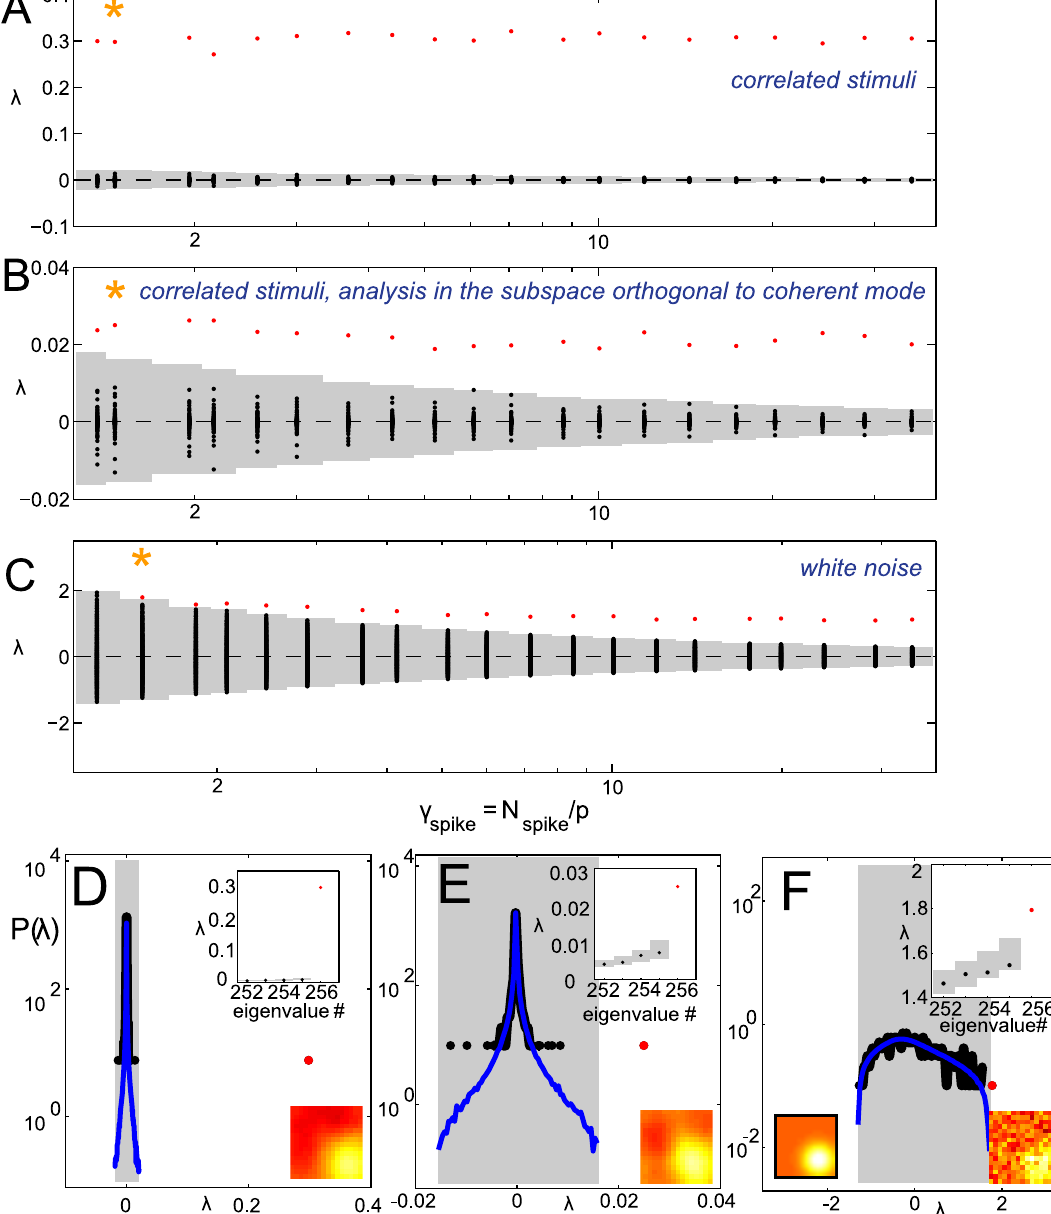
Figure 4. Spike triggered covariance analysis of a model neuron with one relevant feature that has a large component along the coherent mode. Spectra of D C for increasing dataset size in the case of strongly correlated Gaussian noise (A,B) and white noise (C). (A–C) The range of spikes covered is from N spike & 1 : 3 p to N spike & 34 p . Panel B shows the results after evaluating significance in the subspace orthogonal to the coherent mode. Each vertical line shows the result of a single simulation. Significant (insignificant) eigenvalues are shown in red (black), and the ½ 1,99 (cid:2) percentile range of the null distribution (1000 evaluations of D C null ) is shown in gray. (D–F) Gray shaded area is the support of the null distribution, which itself is plotted in blue. The correct feature is found using both stimulus conditions and both the original formulation of the STC method and our proposed correction. N ~ 1995 , N spike ~ 655 for the correlated stimulus condition in panels D and E, N ~ 1995 , N spike ~ 630 for the white stimulus condition in panel F (indicated by an orange star in panels A–C). Insets to panels D–F show the recovered feature (decorrelated in panels D,E) and the nested significance testing which does not affect the results. Black framed inset to panel D shows the model feature. The models were defined such that the mean firing rate remained unchanged between the two stimulus